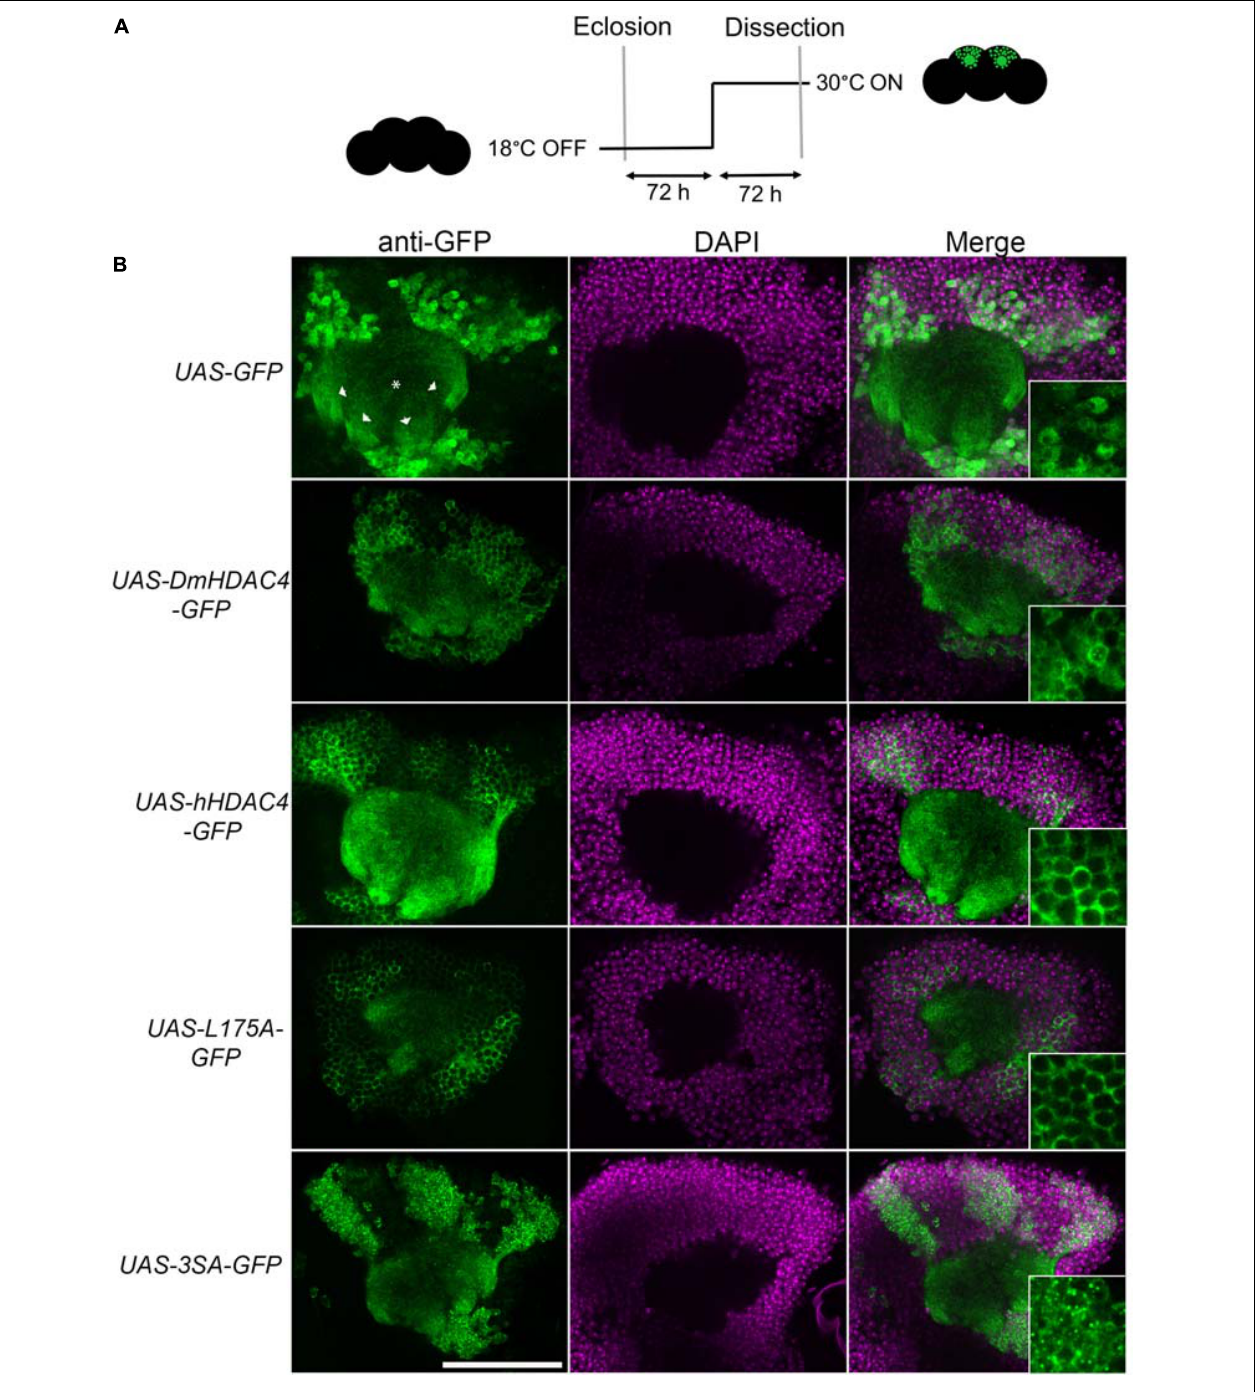
FIGURE 1 | Expression and subcellular localization of GFP-tagged HDAC4 constructs in the mushroom body. (A) Schematic diagram describing the protocol for induction of expression in the adult mushroom body. All genotypes were generated by crossing OK107-GAL4; tubP-GAL80 ts females to males carrying the indicated UAS-transgene. All HDAC4 transgenes were fused in frame to GFP. Flies were raised at 18 ◦ C, at which temperature GAL80 represses GAL4, until after eclosion when the temperature was raised to 30 ◦ C. At this temperature GAL80 is inactivated, allowing GAL4 to induce transgene expression. Brains were dissected after 72 h at 30 ◦ C. (B) Whole-mount brains were subjected to immunohistochemistry with anti-GFP (green) and counterstained with DAPI (magenta). Optical sections (1 µ m) through the calyx of the mushroom body are shown. Asterisks label the calyx and arrowheads indicate the four bundles of Kenyon cell axons that originate in the calyx and project anteriodorsally to form the lobes. Scale bar = 40 µ m. Insets in the right panels are a 4 × magnification of cell